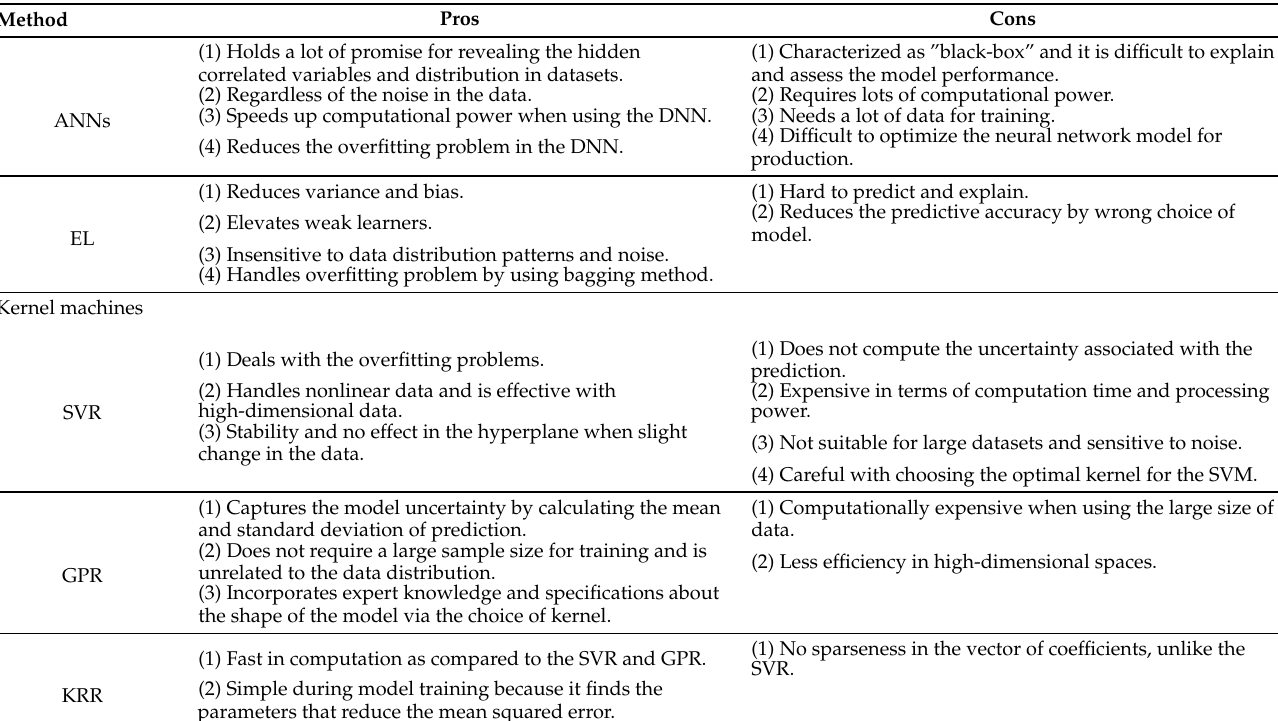
Table 4. Pros and cons of nonlinear nonparametric